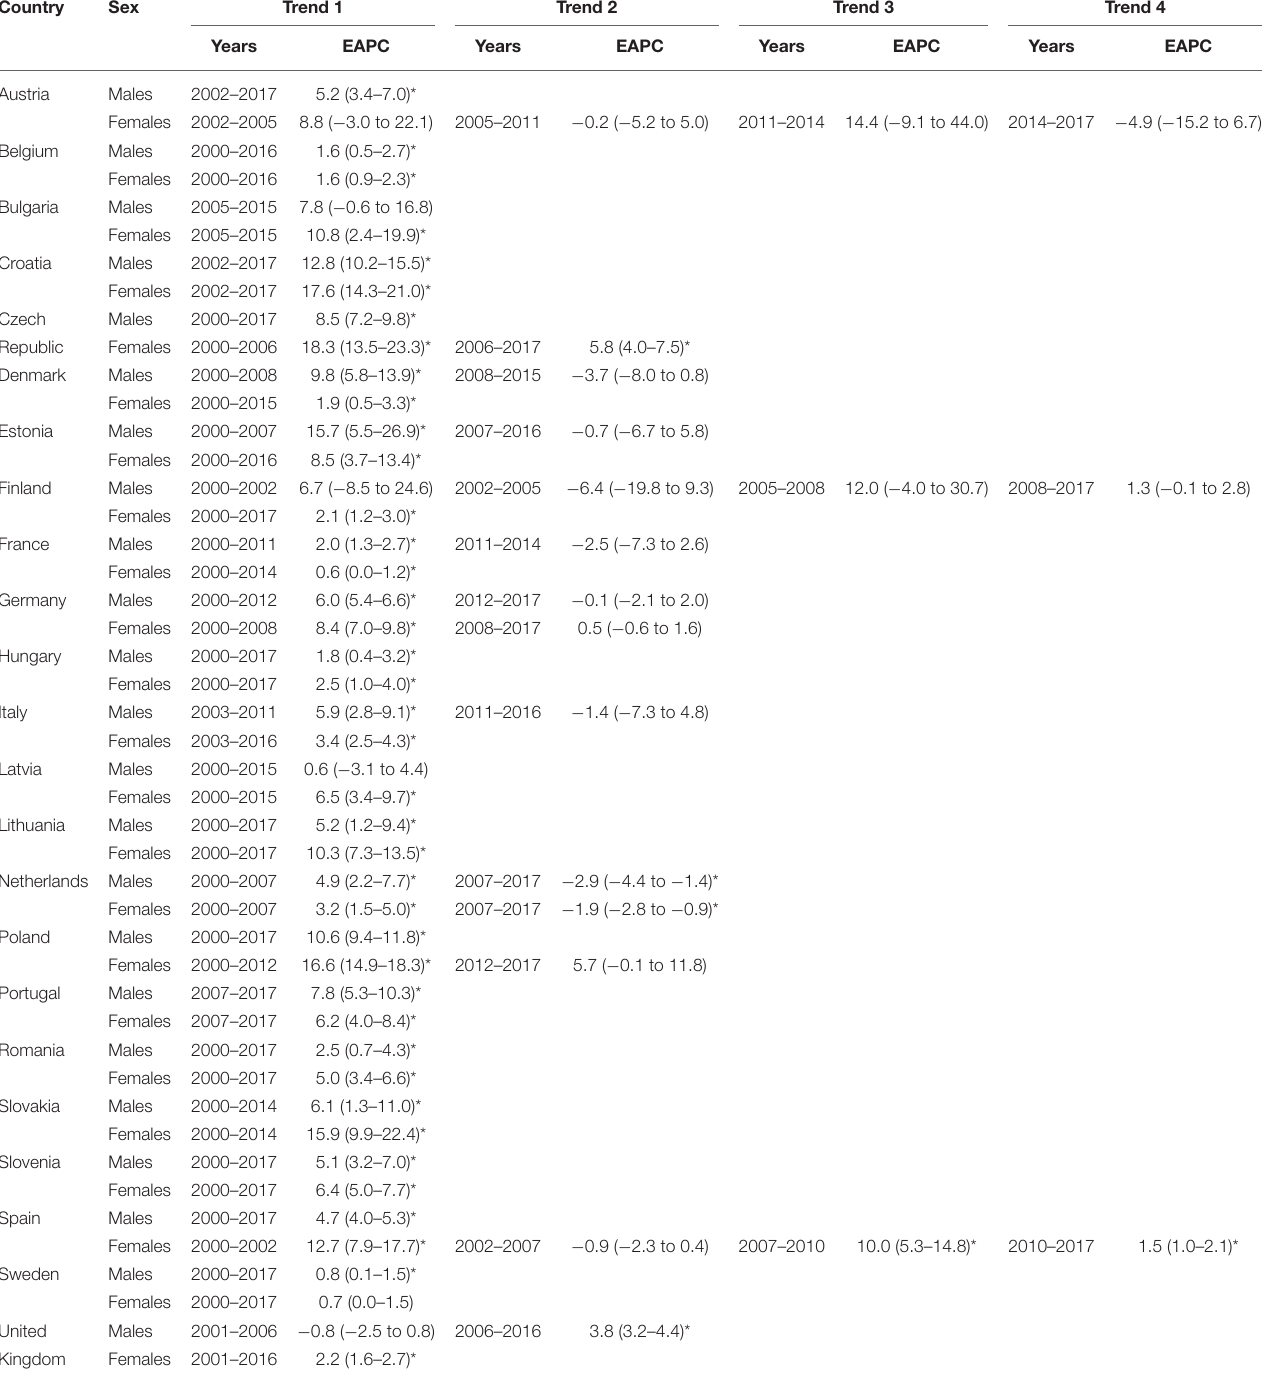
TABLE 2 | Joinpoint regression analysis for mortality from non-rheumatic aortic stenosis for those aged > 45 years in Europe from 2000 to 2017.